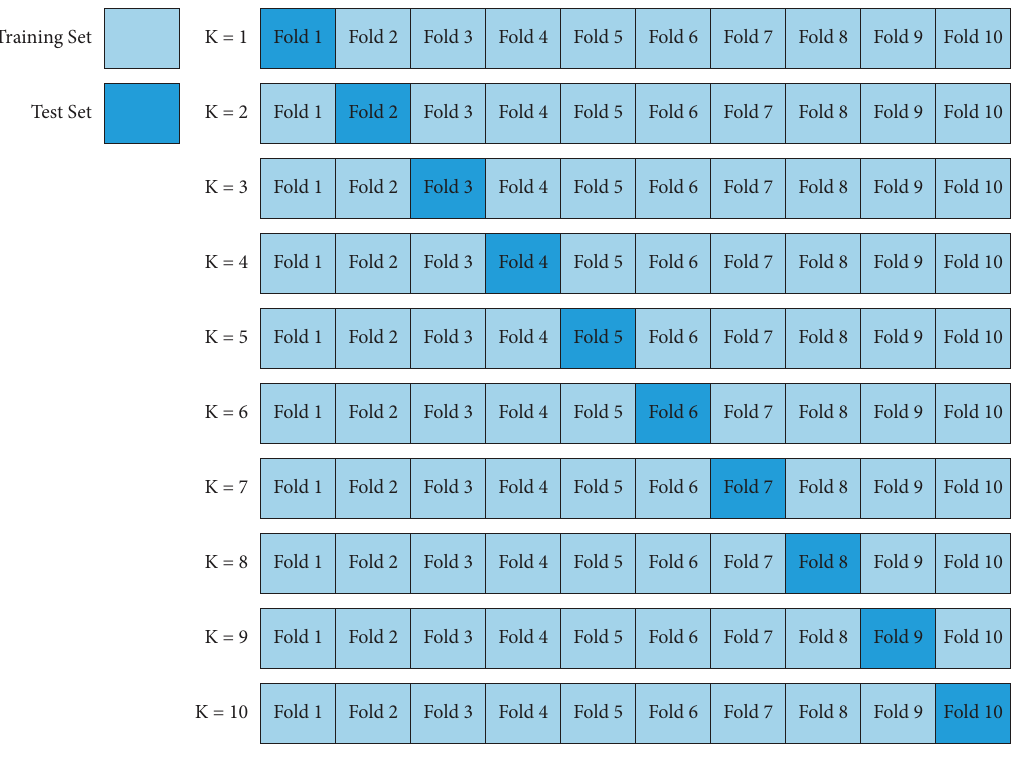
Figure 4: 10-fold cross-validation procedure. Table 16: Classifer output with 10-fold